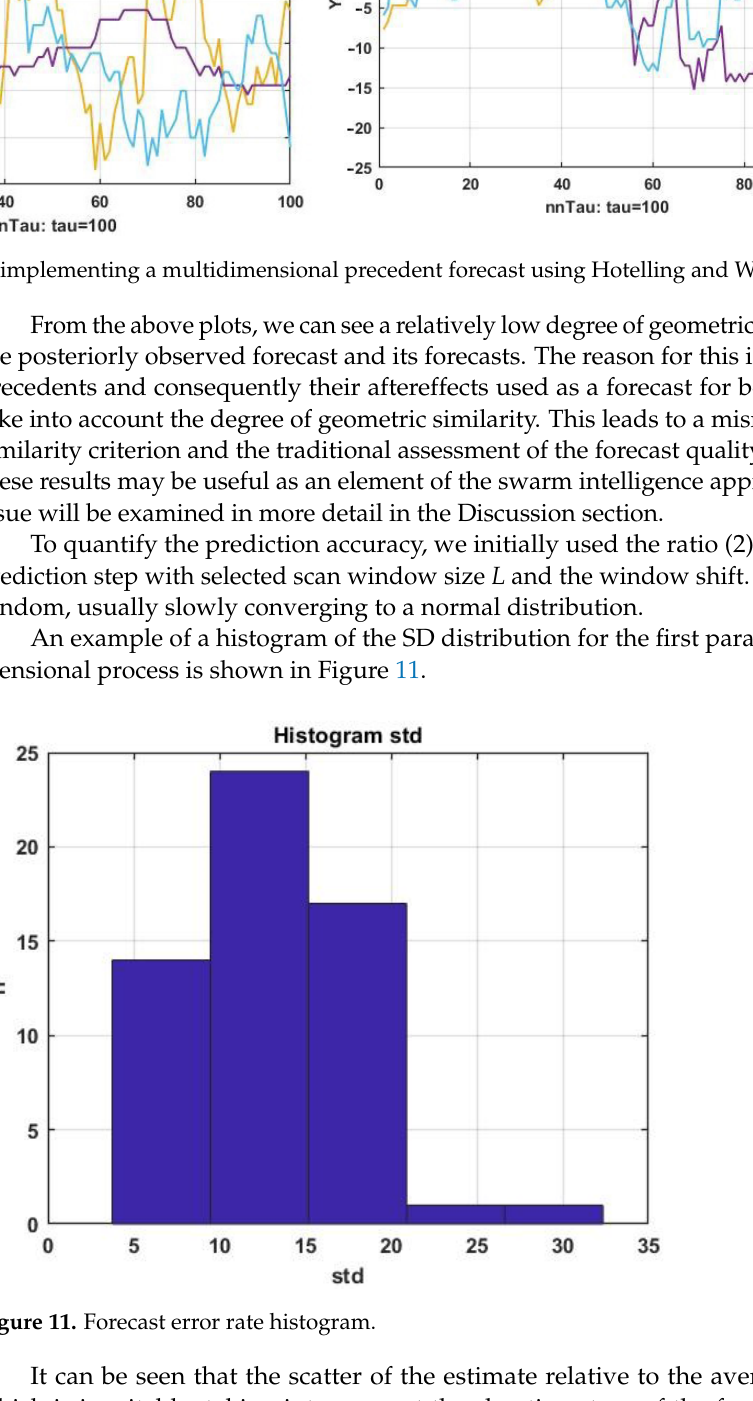
Figure 10. Two examples of implementing a multidimensional precedent forecast using Hotelling and Wilkes metrics.